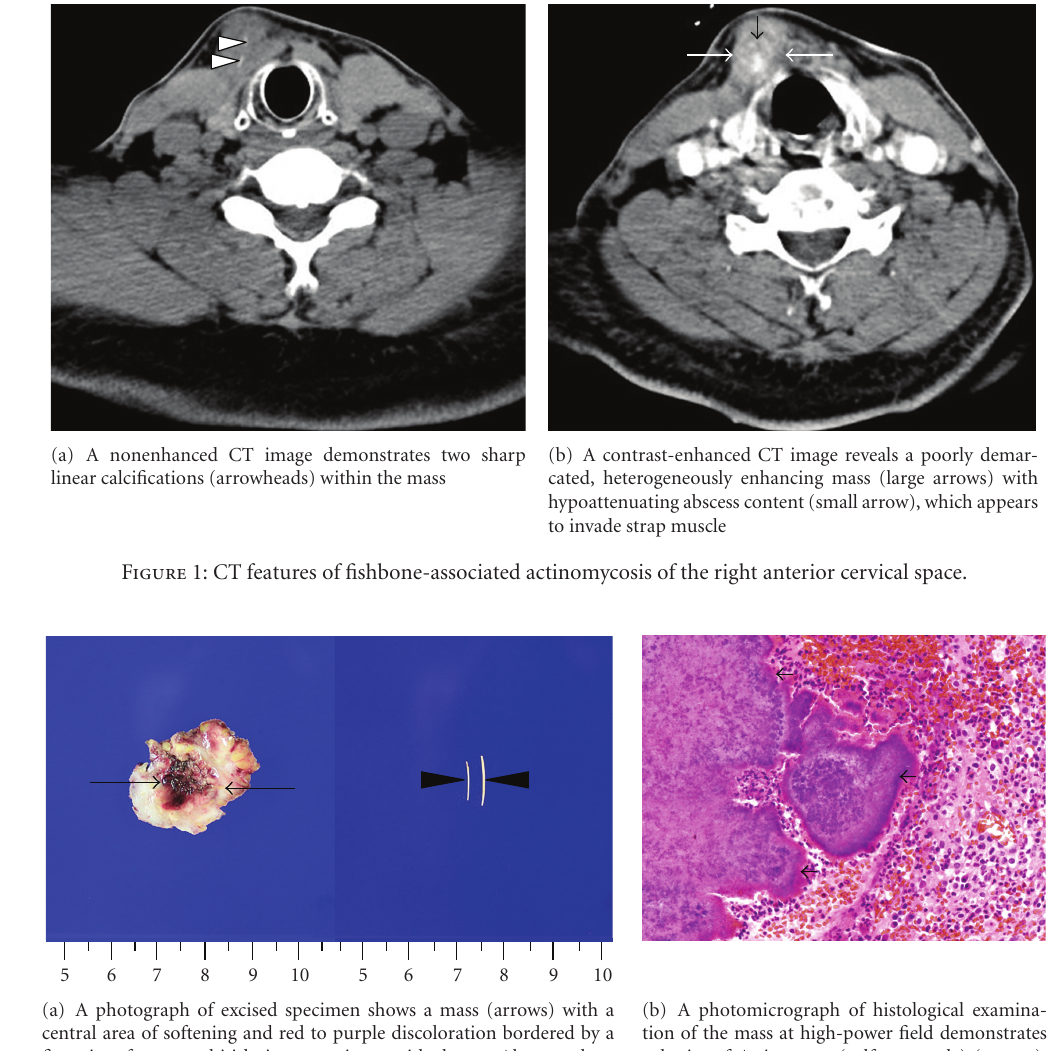
Figure 2: Gross and microscopic features of fishbone-associated